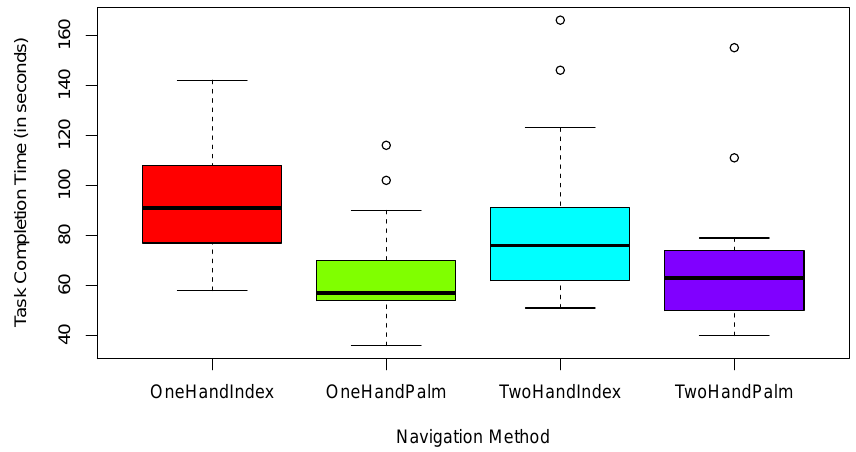
Figure 8. Boxplot of task completion time of the proposed navigation methods.